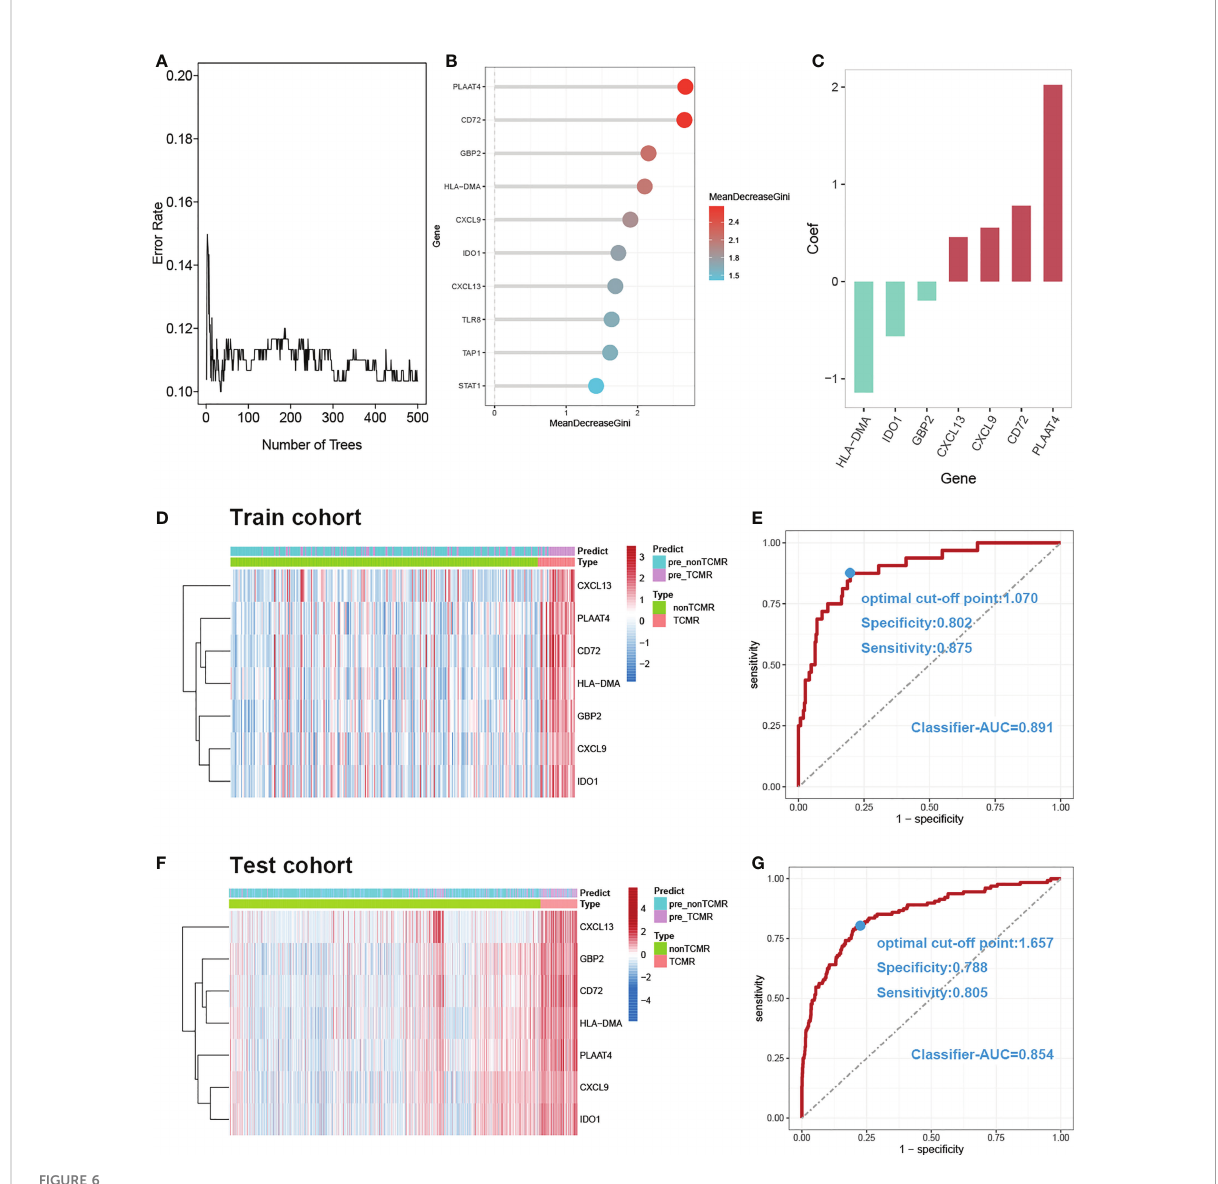
FIGURE 6 Construction and veri fi cation of diagnostic prediction model. (A) Random forest error rate plot. (B) Mean decreased gini of genes pro fi les. (C) Coef fi cient of seven screened DE-MRIGs in thedignostic prediction model. (D) Heatmap of identi fi ed DE-MRIGs in train cohort and (F) test cohort. (E) ROC curve of the model: the AUC, optimal cut-off point, speci fi city and sensitivity of classi fi er for discriminating TCMR in train cohort and (G) test cohort. DE-MRIGs, different expression m6A-related immune genes; ROC, receiver operating characteristic; AUC, areas under the